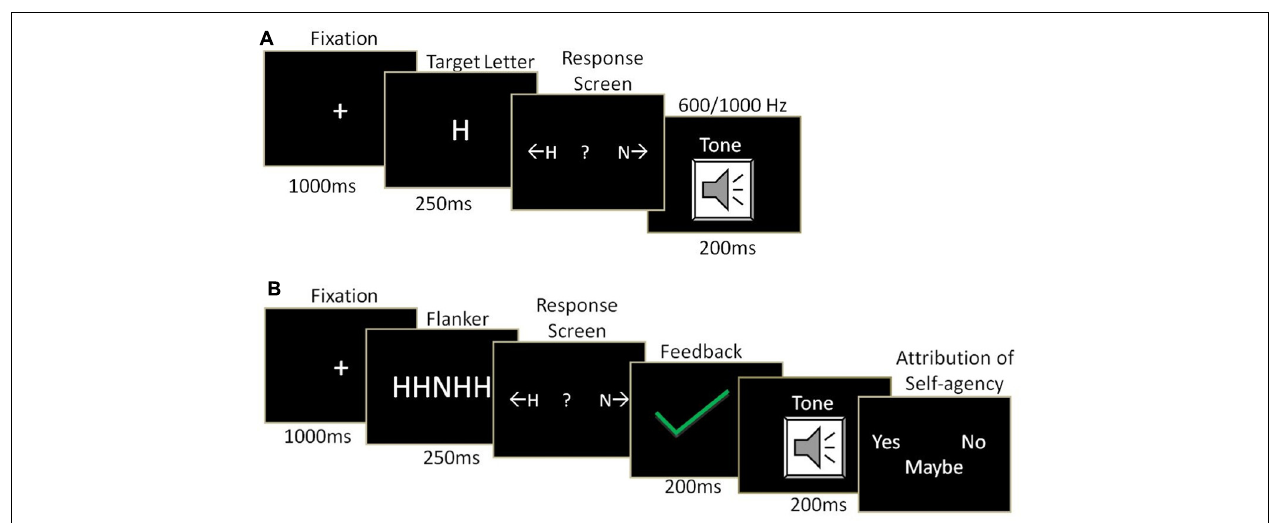
FIGURE 1 | Trial structure of (A) training phase and (B) test phase. In training phase, participants learned the association between action (key press towards target letter) and outcome (tone). In test phase, target letter was flanked by either congruent